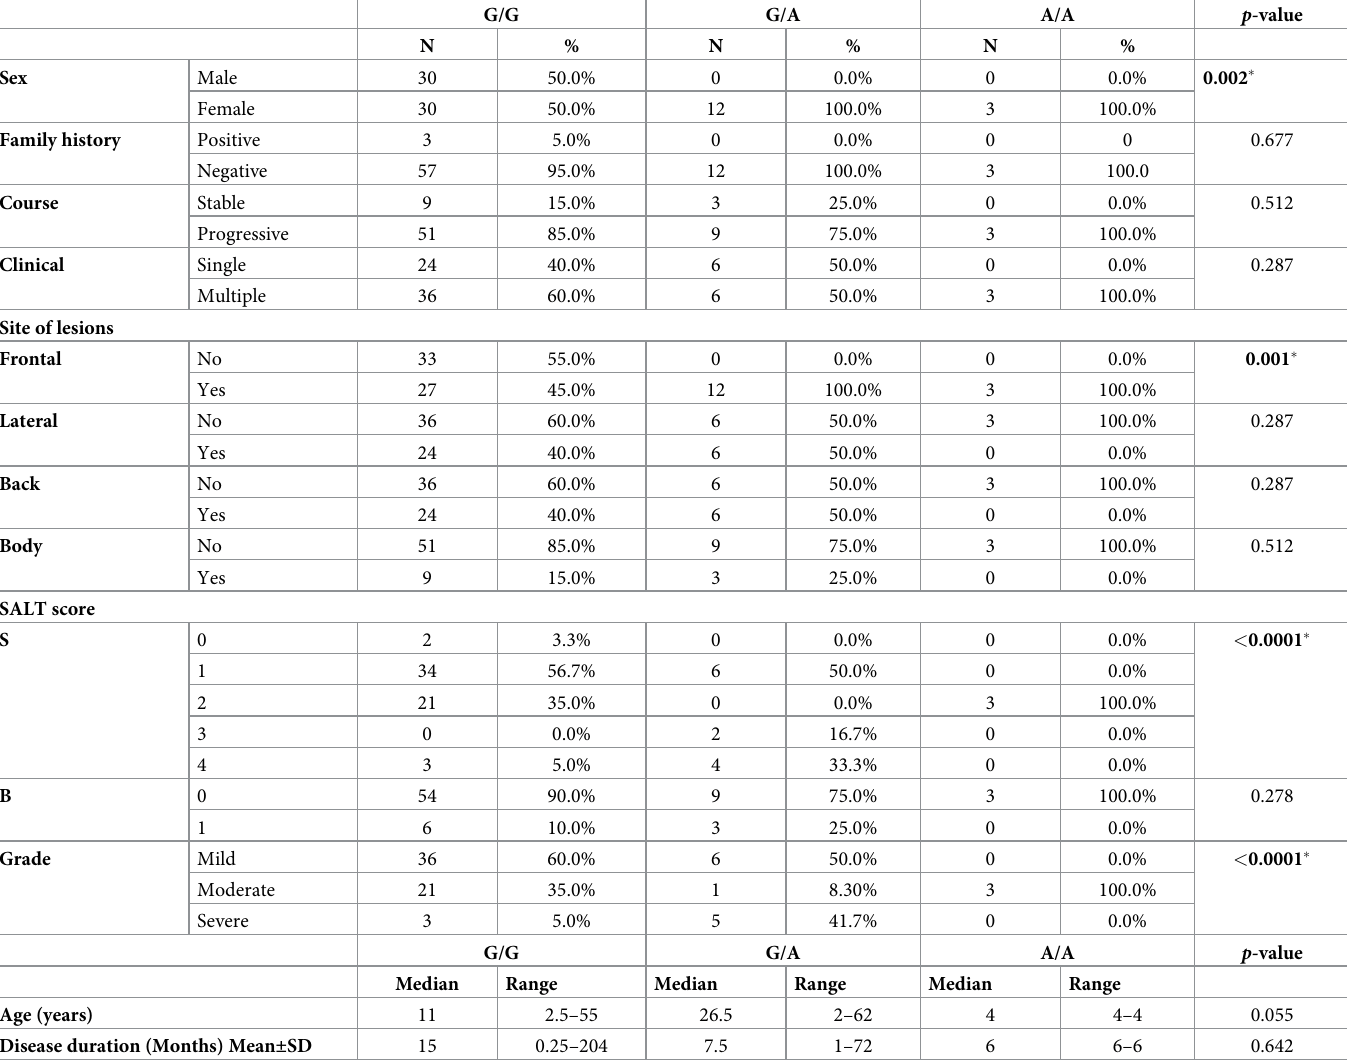
Table 5. Relation between TNF- α -308-G/A and clinical characteristics in alopecia areata